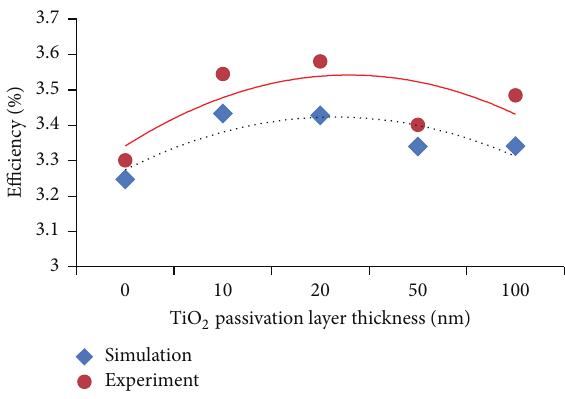
Figure 4: Resistance of simulated DSC. Table 3: Performance of DSC with various thicknesses of TiO 2 passivation layer.